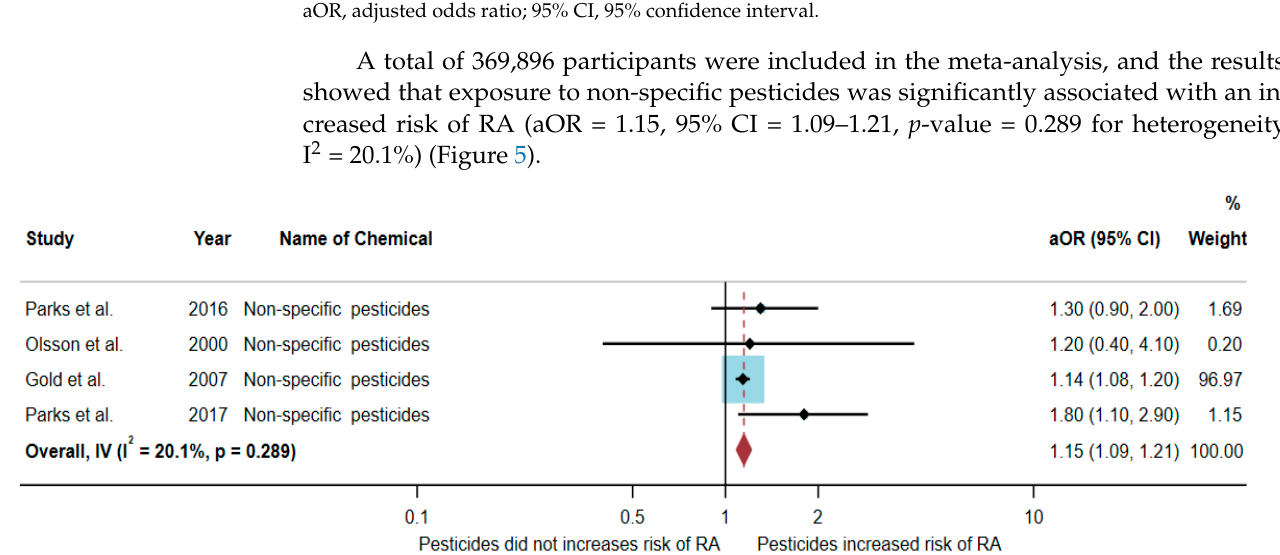
Table 4. The association between exposure to non - specific pesticides and RA development.